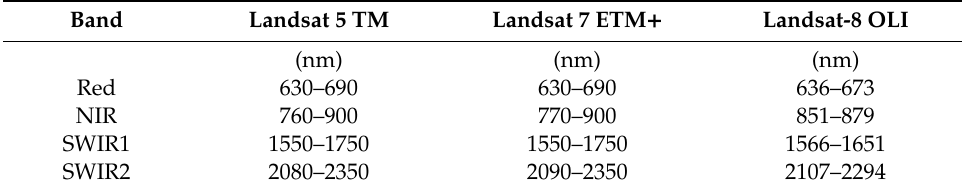
Table 1. Spectral bands of Landsat 5, 7, and 8